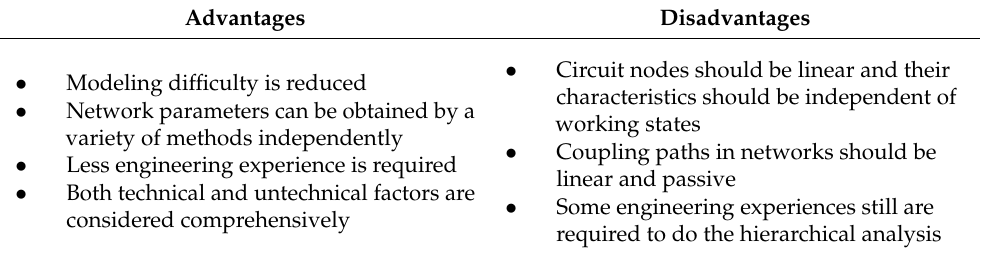
Table 1. Advantages and disadvantages of model based analysis and improvement strategy.